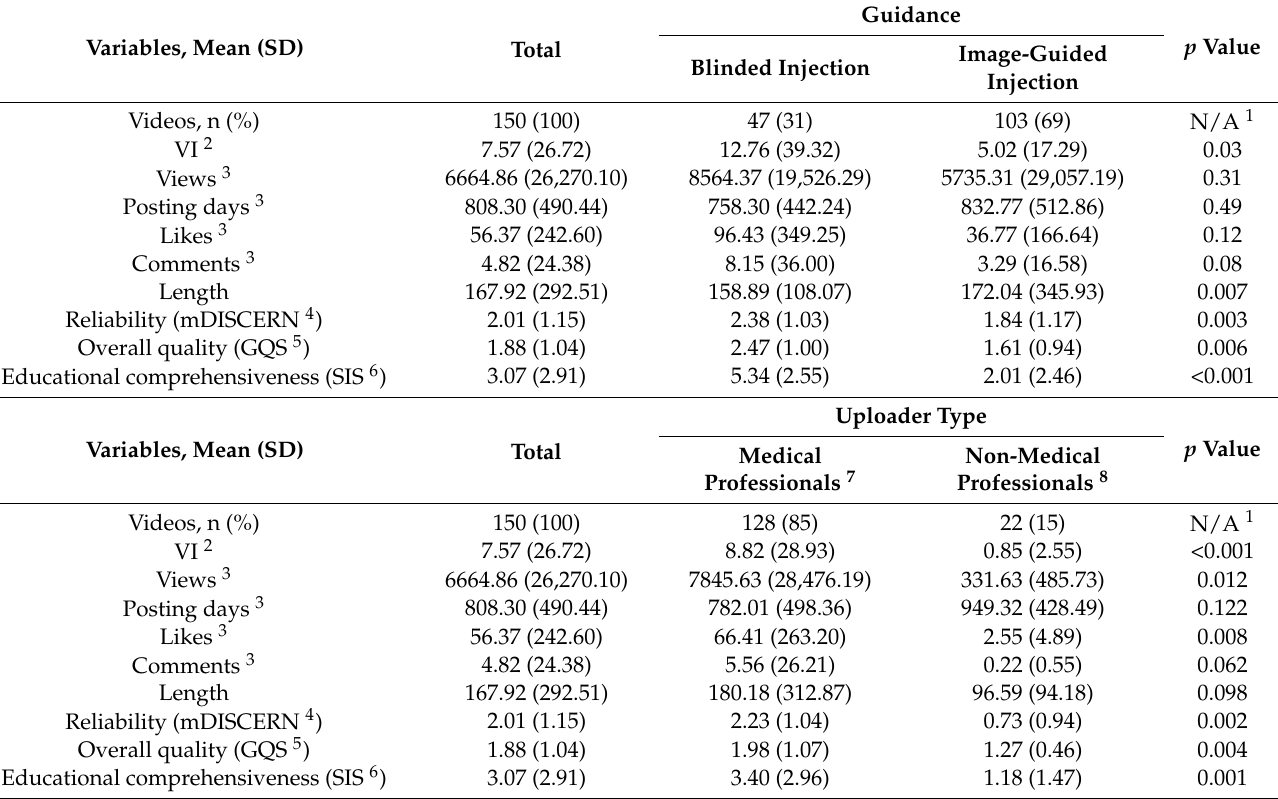
Table 2. Basic characteristics of the included